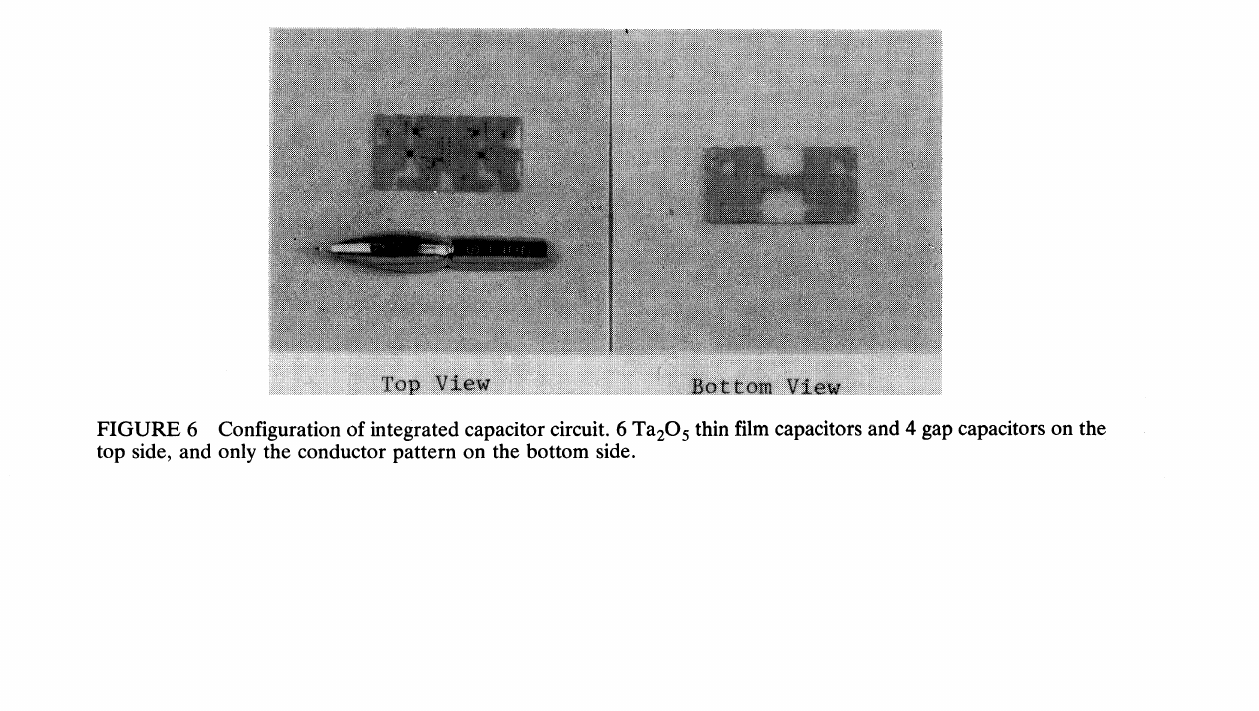
FIGURE 7 Variation of capacitance on integrated capacitor circuit. Cpl, Cps, Cx and Cx are adjustable capacitors.